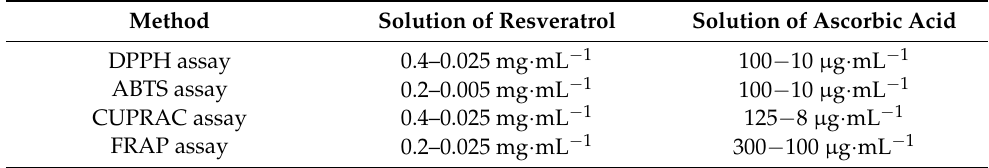
Table 1. Ranges of resveratrol and ascorbic acid concentrations used in studies of antioxidant properties.